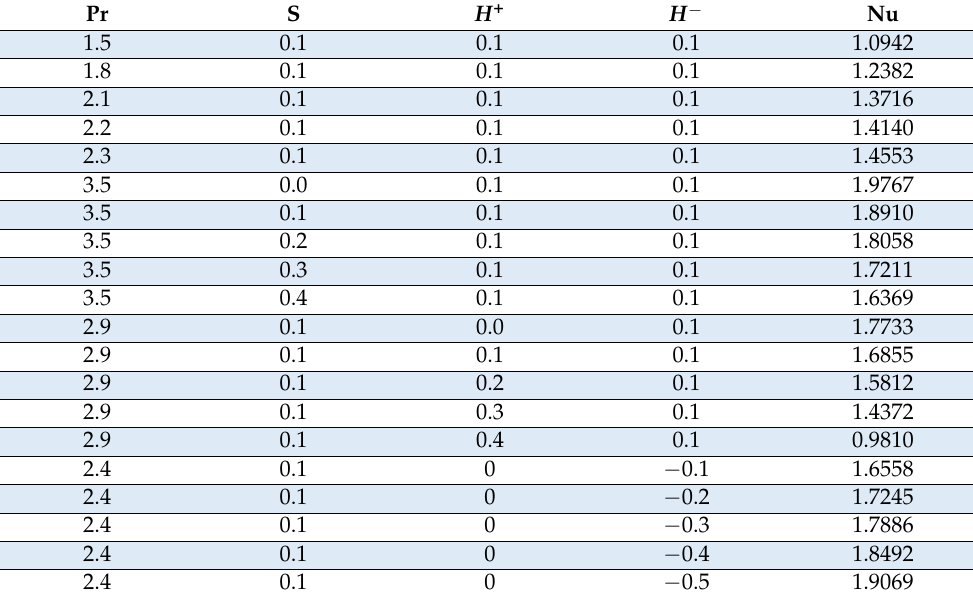
Table 1. Nusselt number variations subject to Flow Regime-I.